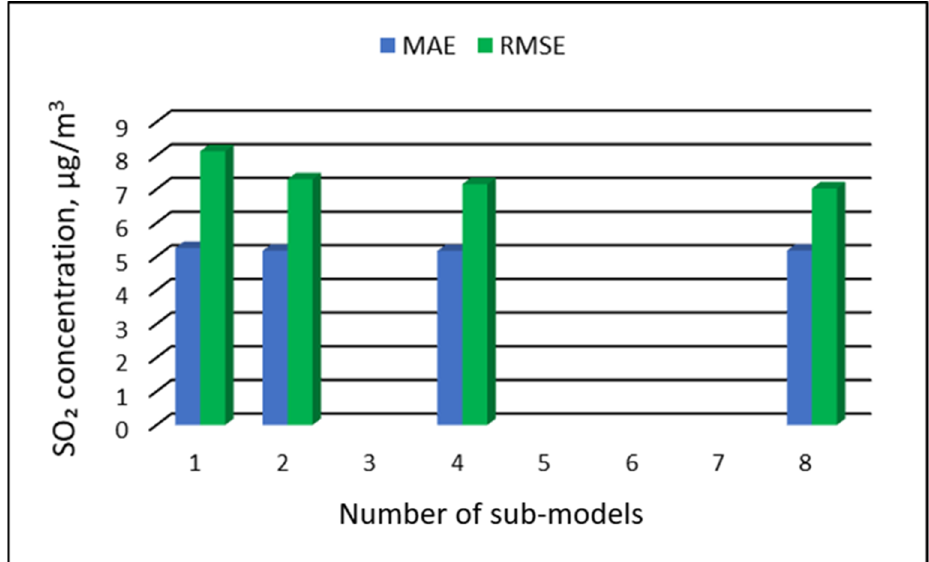
Table 16. Values of approximation errors of SO 2 concentrations in PVS models, Z ł oty Potok 2011– 2016.